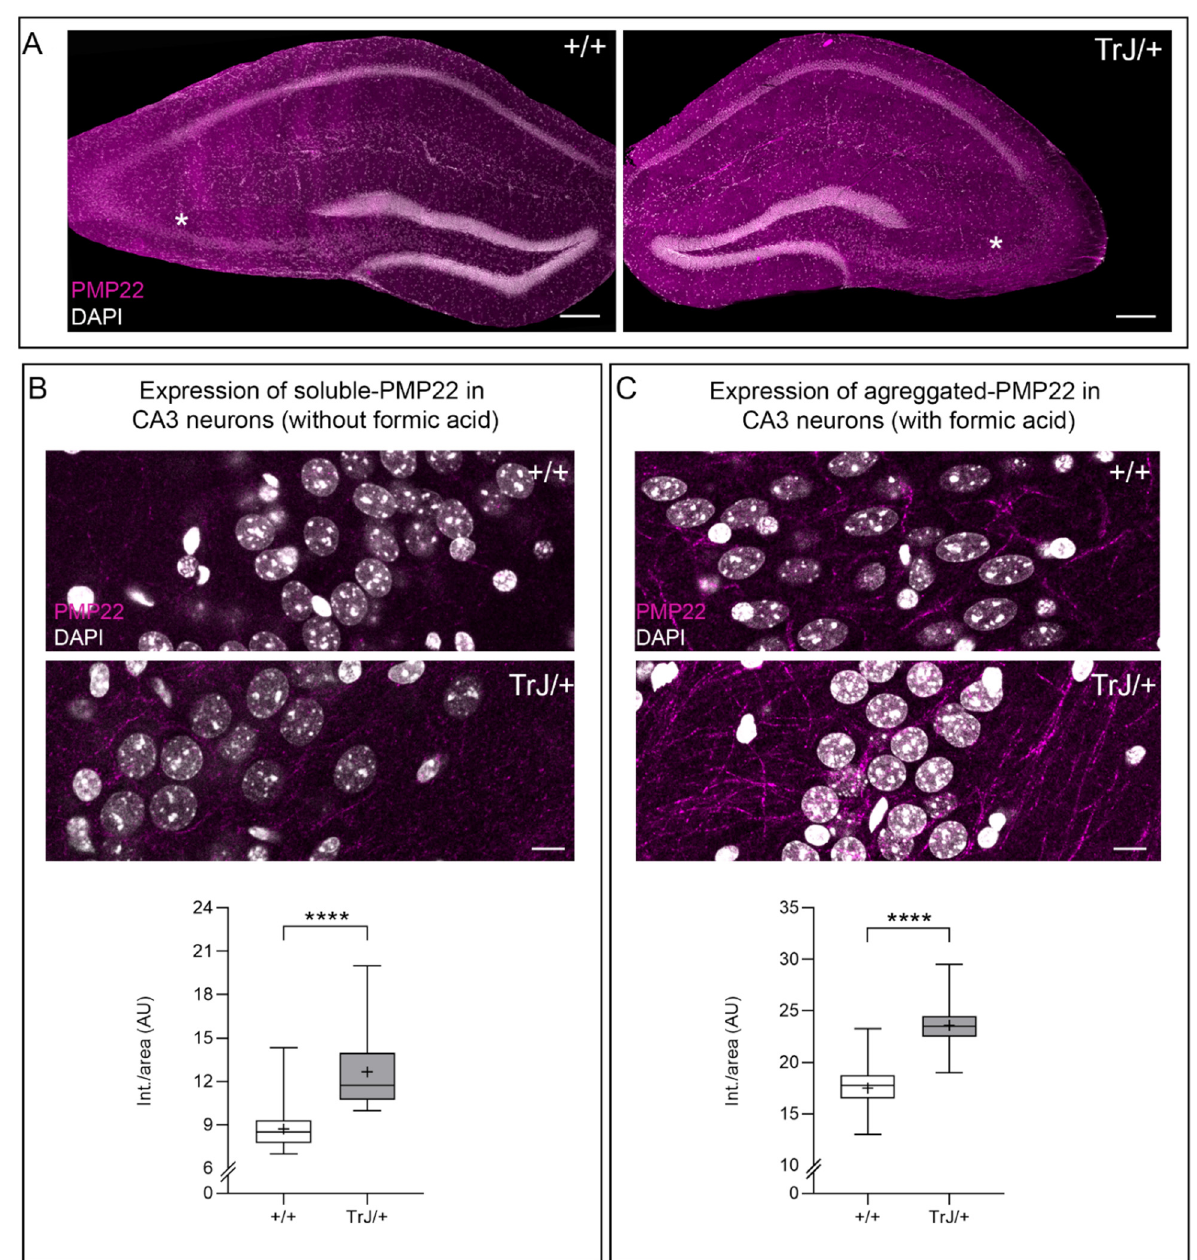
Figure 5. Localization of aggregated and soluble PMP22 in the hippocampus of adult mice. ( A ) A tail scan image of the whole hippocampal formation of both +/+ and TrJ/+ genotypes. The asterisk (*) indicates hippocampal CA3 neurons regions. Nuclear domains were enlightened by specific DAPI staining. Expression of PMP22 (magenta) aggregates in the hippocampus after epitope retrieval (70% formic acid), in 60 µ m thick vibratome sections of both +/+ and TrJ/+. ( B ) PMP22 aggregated is shown in the CA3 pyramidal neurons of both +/+ and TrJ/+ mice. ( C ) Specific PMP22 showed significant differences between genotypes, with the highest values observed in TrJ/+ mice, analyzed by the Mann–Whitney U-test ( p < 0.0001, n = 4 for each genotype). Scale bar for A = 200 µm for all panels. Scale for B = 10 µm for all panels. **** p < 0.0001. The mean is shown as “+”.